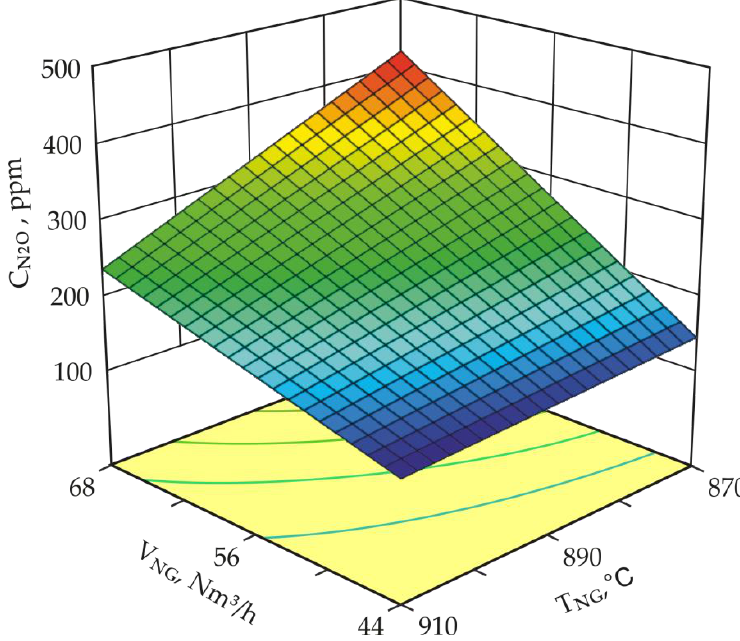
Figure 3. The dependence of N 2 O concentration in the nitrous gas downstream of the PKR catalyst layer on the nitrous gas temperature and nitrous gas flow rate.